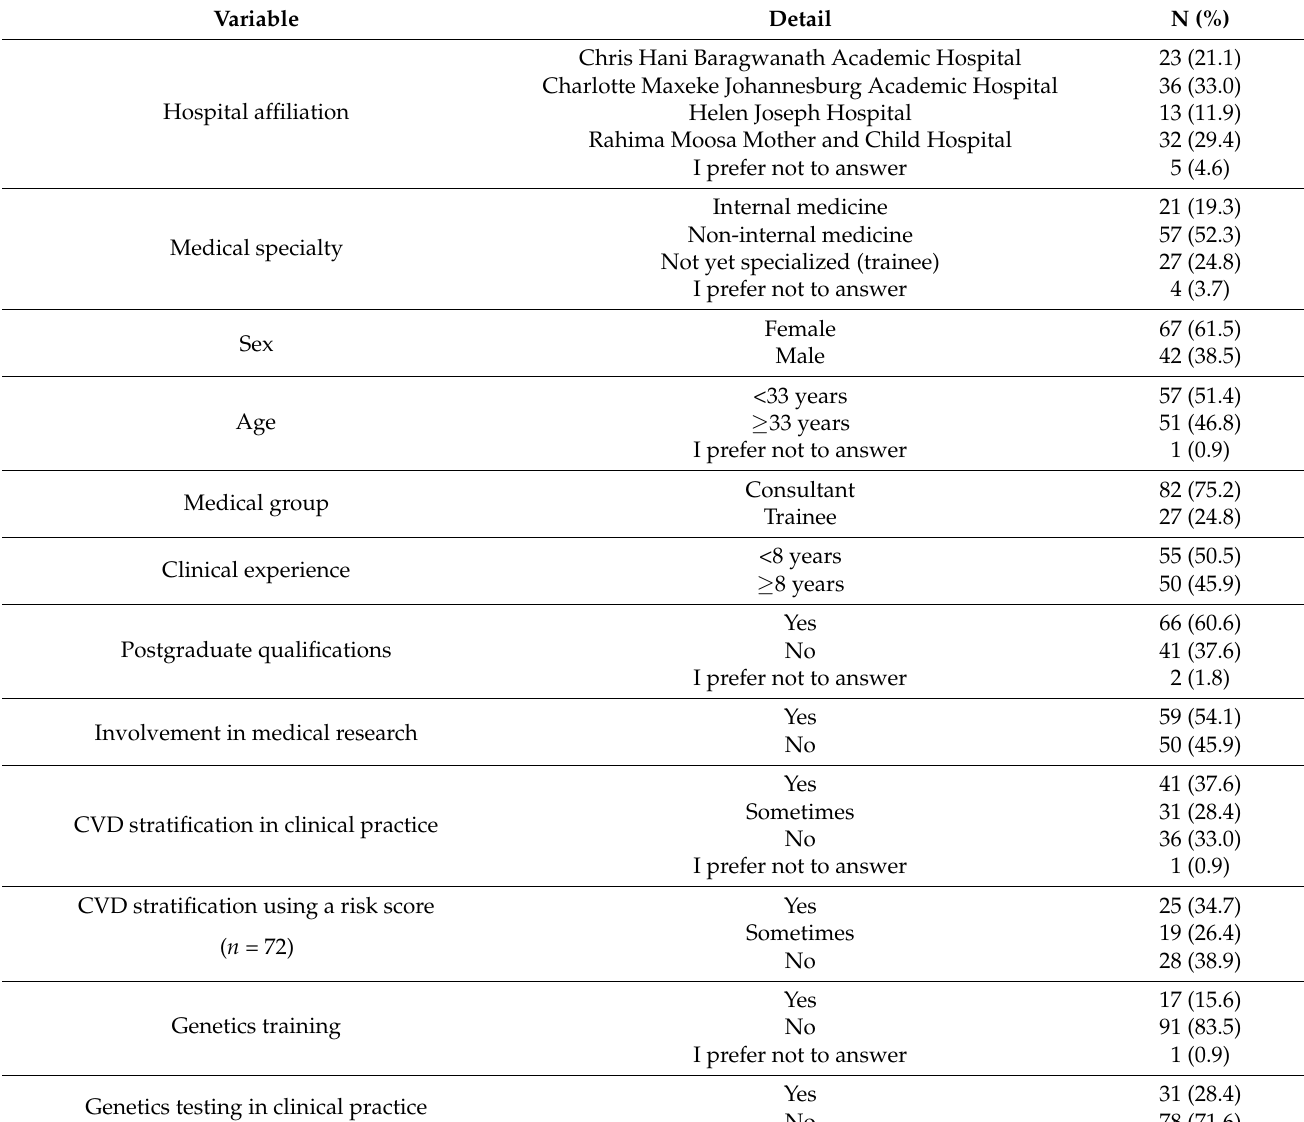
Table 3. Respondents’ demographics, professional characteristics and study-related clinical exposures ( n =